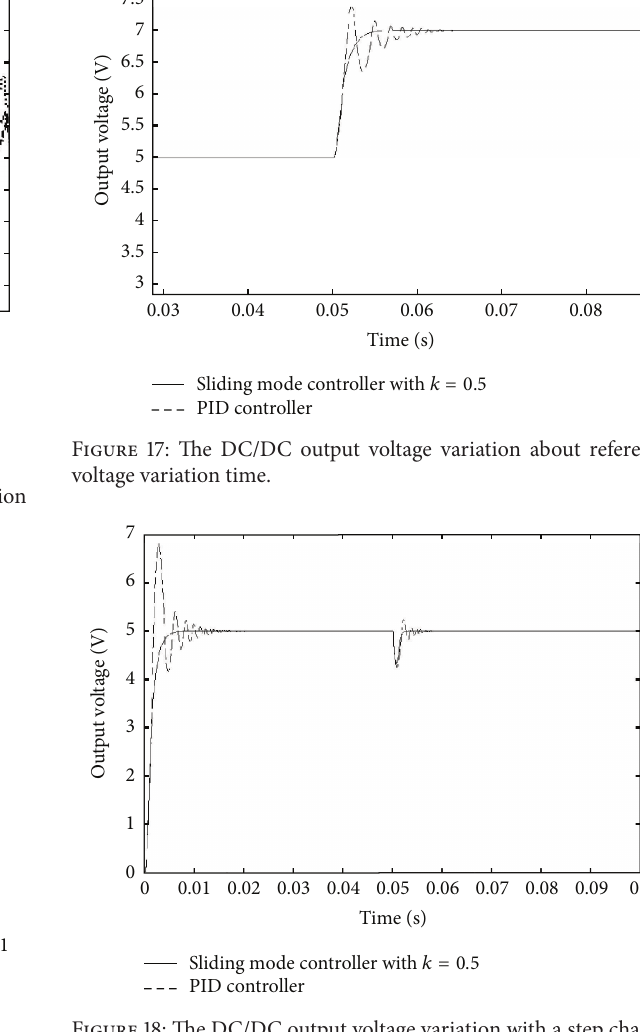
Figure 18: The DC/DC output voltage variation with a step change in load.